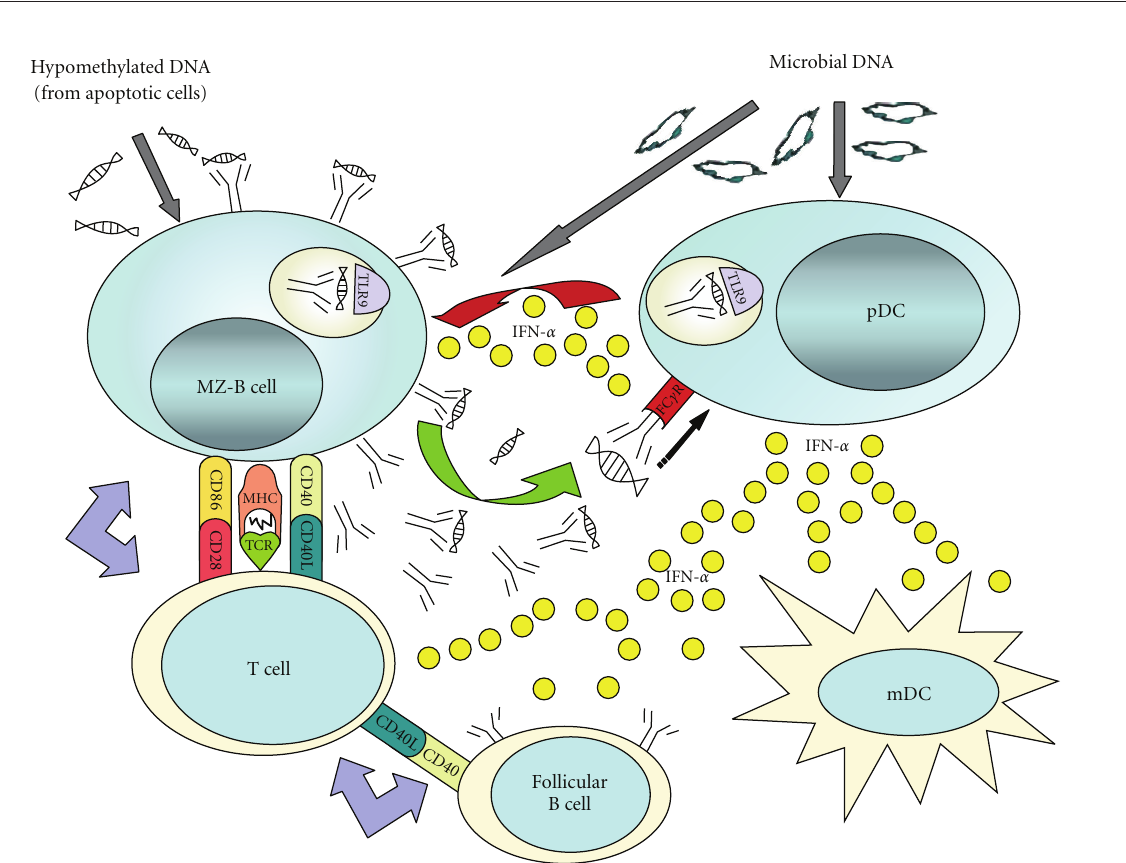
Figure 8: The innate model of lupus